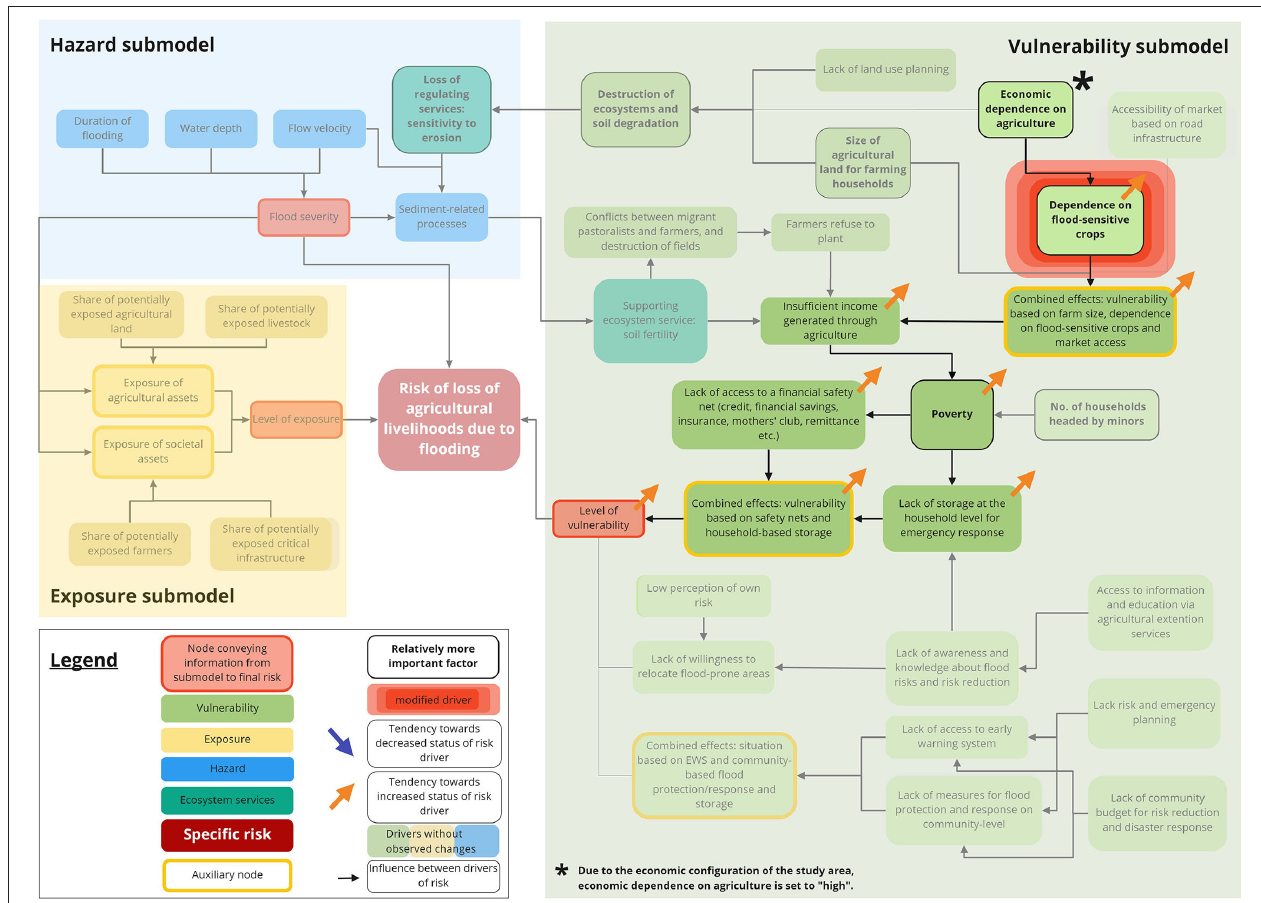
FIGURE 4 | First illustrative scenario depicting the system behavior if dependence on flood-sensitive crops is observed to be